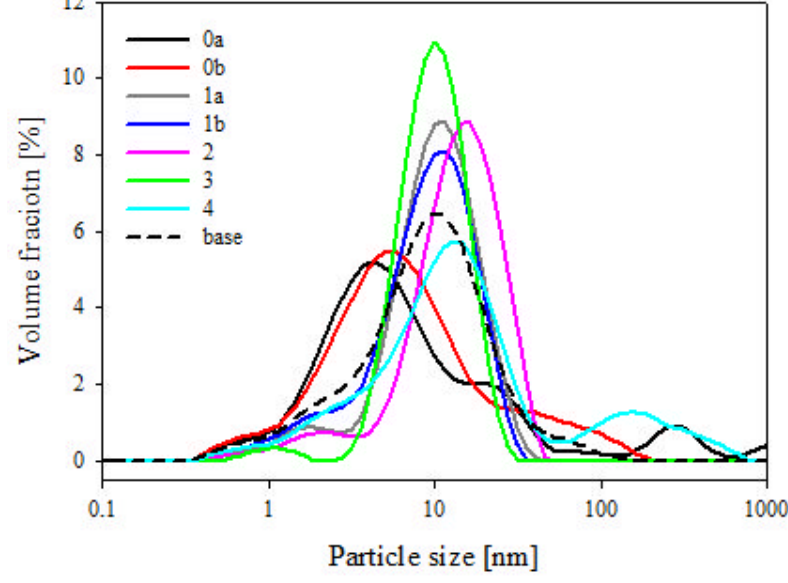
Figure 6. Separation of particles of fractionated diatomaceous earth by size.